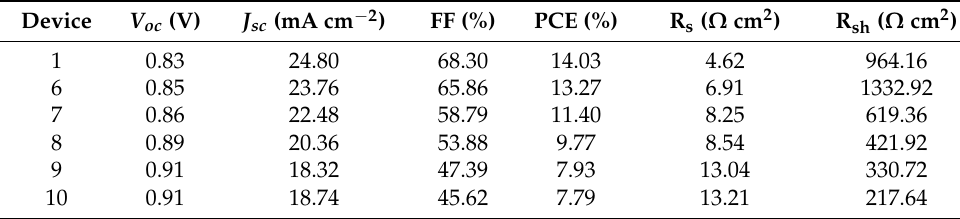
Table 2. Performance parameters of devices 1, 6 to